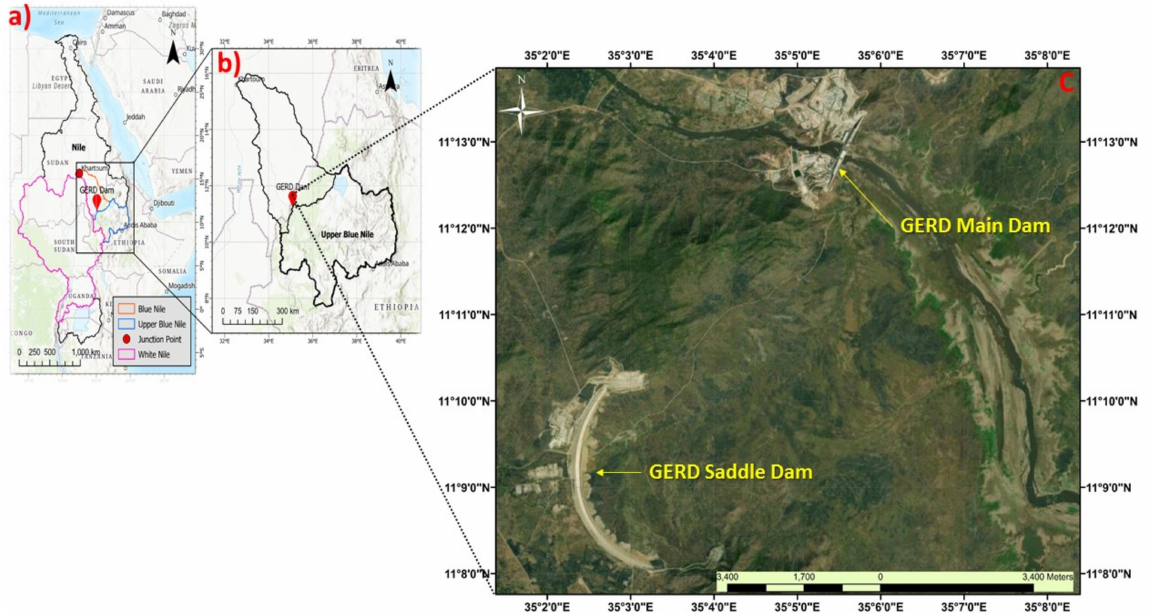
Figure 1. Insert Figure ( a ) shows the Nile River basin and the sub-basins—White Nile River basin and Blue Nile River basin. The White Nile River and the Blue Nile River merge at Khartoum, Sudan, which is shown as the Junction Point in the figure. Inset Figure ( b ) shows the Blue Nile River basin along with the location of GERD Dam near the Ethiopian-Sudanese border. Insert Figure ( c ) shows the GERD project location and GERD components including the Main and Saddle Dams. Inserts ( a , b ) are adopted from [3] with